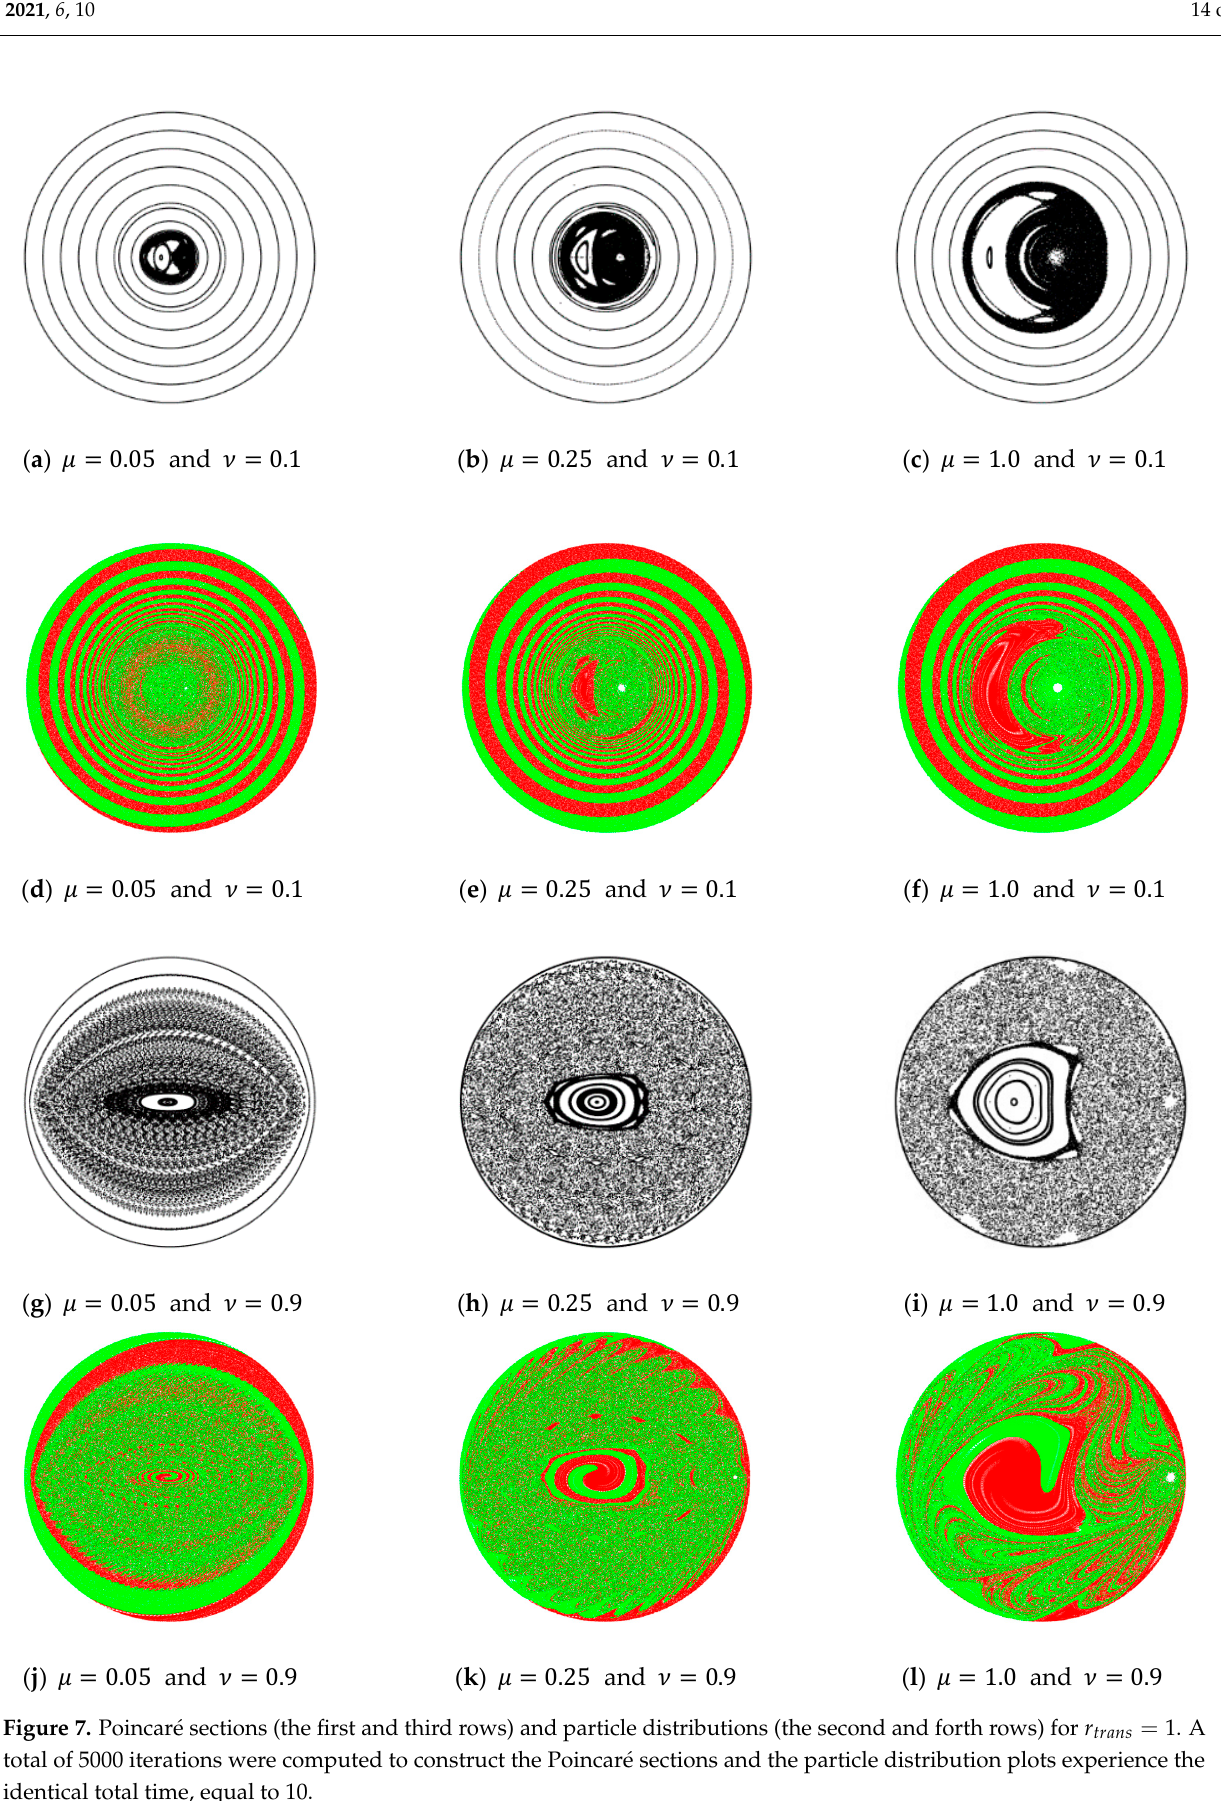
Figure 7. Poincar é sections (the first and third rows) and particle distributions (the second and forth rows) for r trans = 1. A total of 5000 iterations were computed to construct the Poincar é sections and the particle distribution plots experience the identical total time, equal to 10.